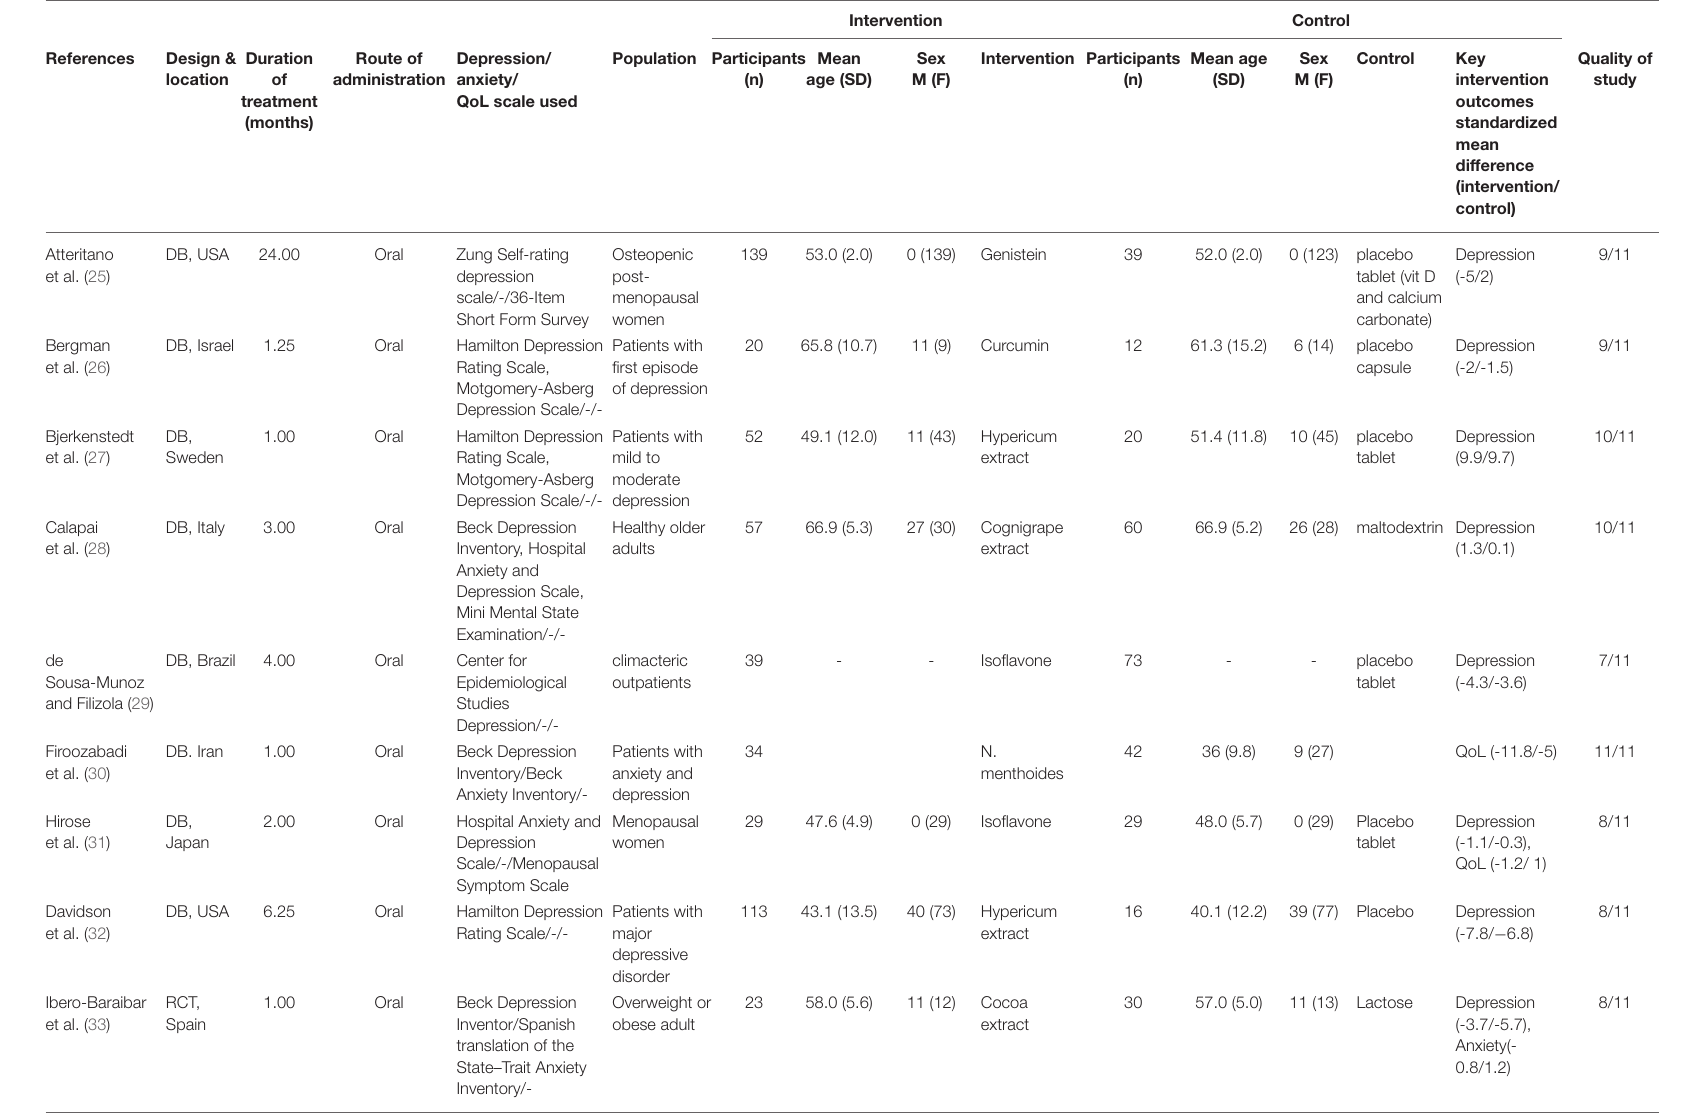
TABLE 1 | Summary of studies included in